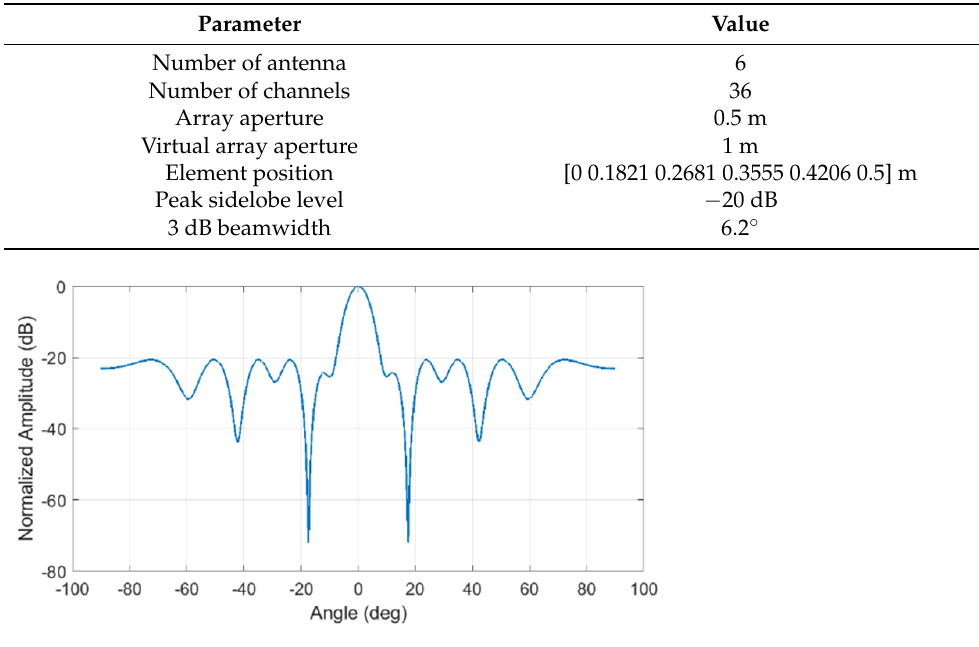
Figure 3. Array beam pattern after GA optimization. The 3 dB beamwidth is 6.2° and the side lobes are all below − 20 dB without a gating lobe.